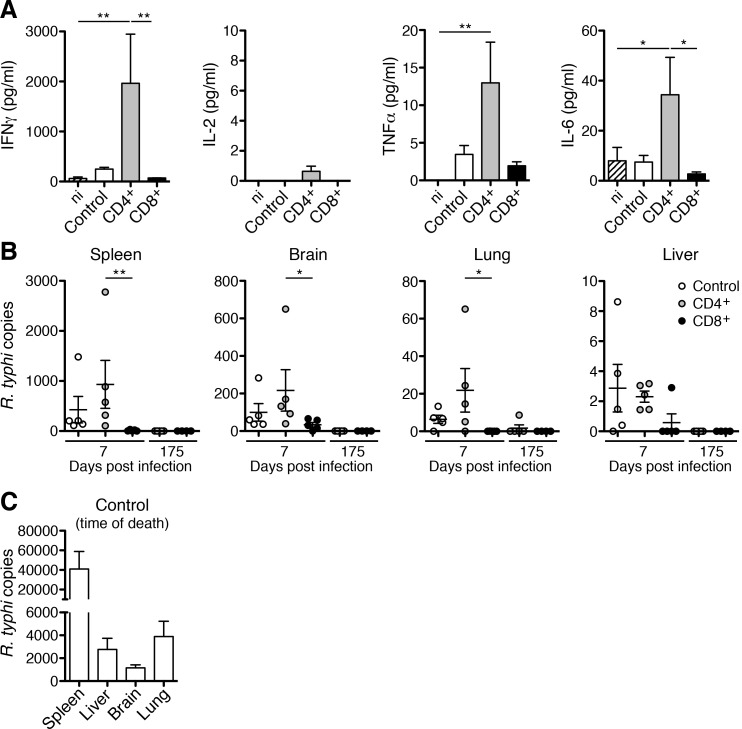
Adoptively transferred CD4+ T cells produce IFNγ and TNFα and both CD4+ and CD8+ T cells provide long-term control of R. typhi in vivo.From the same mice as described in Fig 3 cytokine levels (y-axis) were determined in plasma on day 7 post infection (n = 7 for each group as indicated on the x-axis). In addition, plasma from non-infected PBS-treated mice (ni; n = 6) was analyzed. Statistical analysis was performed by One-way ANOVA (Kruskal Wallis test followed by Dunn´s post test). Asterisks indicate significant differences (*p<0.05, **p<0.01) (A). Bacterial content (y-axis) in the organs indicated above was quantified by qPCR in each group (R. typhi-infected control mice: open circles, CD4+ T cell recipients: gray circles; CD8+ T cell recipients: black circles) on day 7 (n = 5 for each group) and when the experiment was terminated on day 175 (n = 5 for control mice and CD4+ T cell recipients; n = 4 for CD8+ T cell recipients) post infection (x-axis). Each symbol represents a single mouse. Statistical analysis was performed by One-way ANOVA (Kruskal Wallis test followed by Dunn´s post test). Asterisks indicate significant differences (*p<0.05, **p<0.01) (B). Bacterial content was quantified in R. typhi-infected control animals (n = 5) at the time of death in the indicated organs (x-axis) (C).